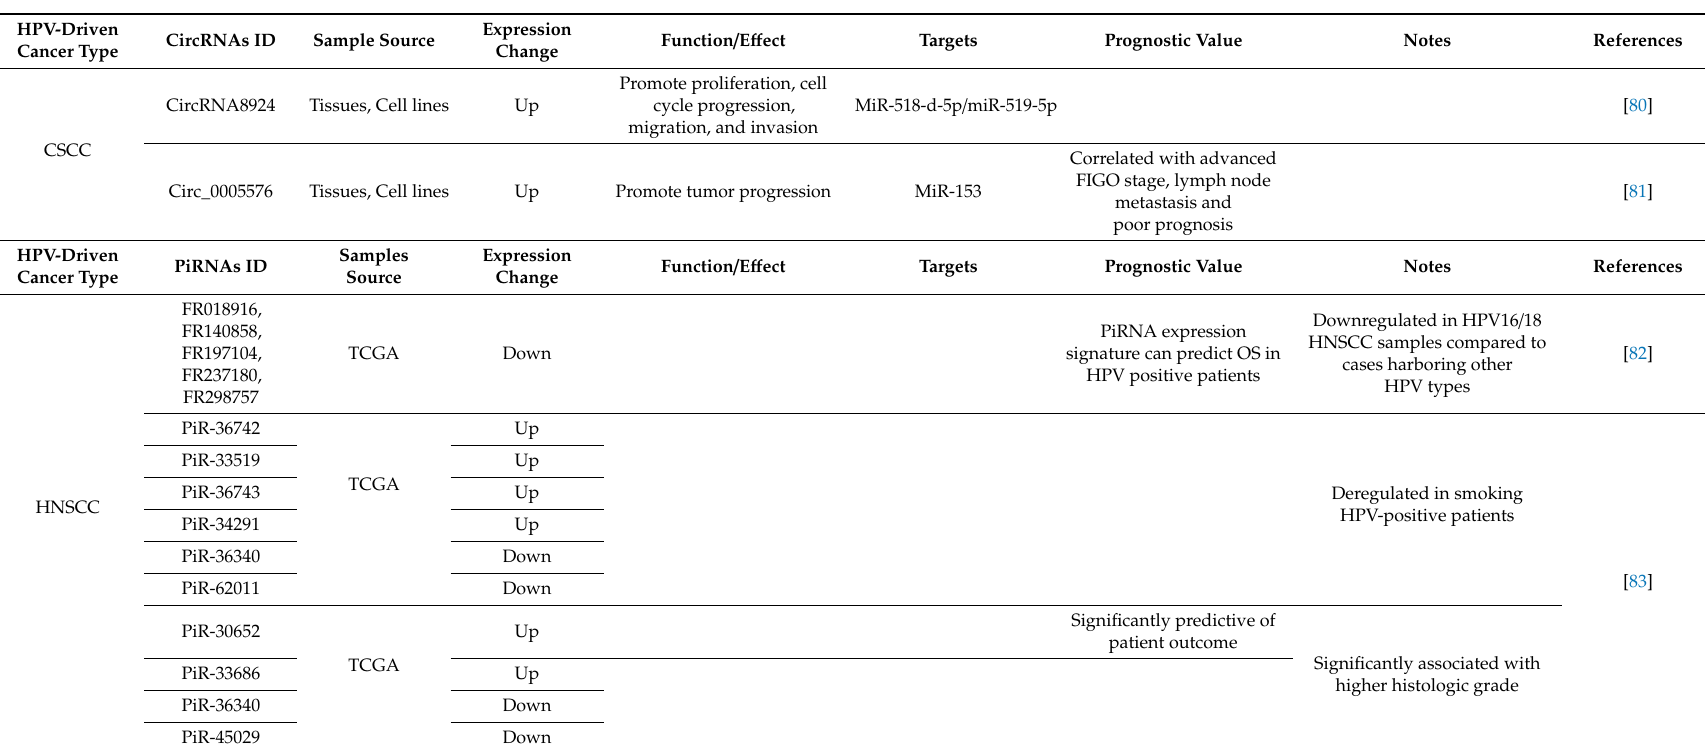
Table 2. Non-coding RNA and PIWI-like proteins expression in Human Papilloma Virus (HPV)-driven